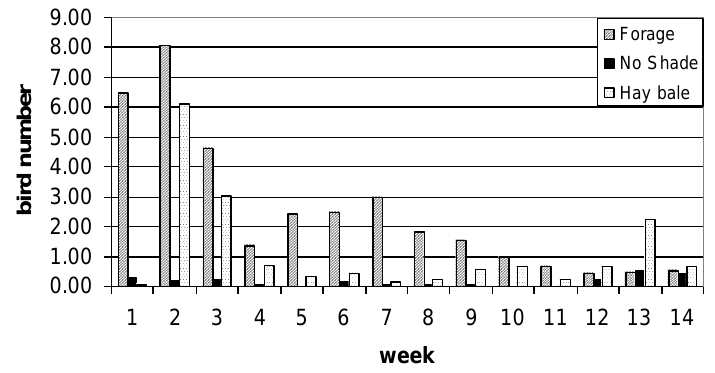
Figure 5. Weekly average number birds in forage, hay bale enriched and non shade areas over 14